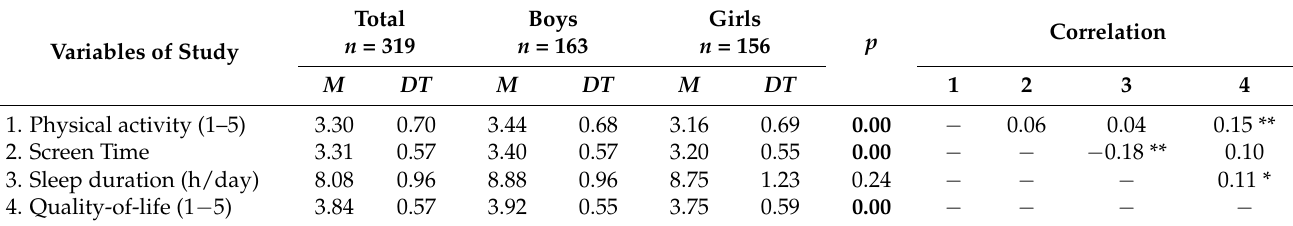
Table 1. Descriptive statistics and bivariate correlations of the variables studied.